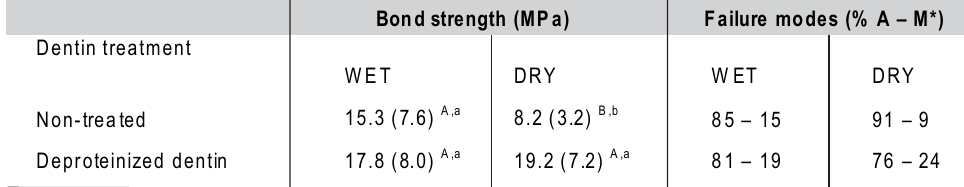
Means followed by different uppercase letters in the same line and lowercase letters in the same column are significantly different at P < 0.05. *Percentage of adhesive (A) and mixed (M) failures.